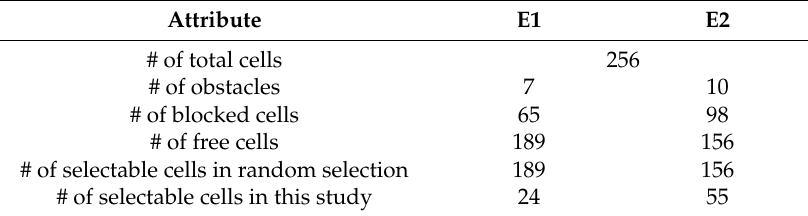
Table 4. Comparison of selectable free cells in Environments 1 and 2.